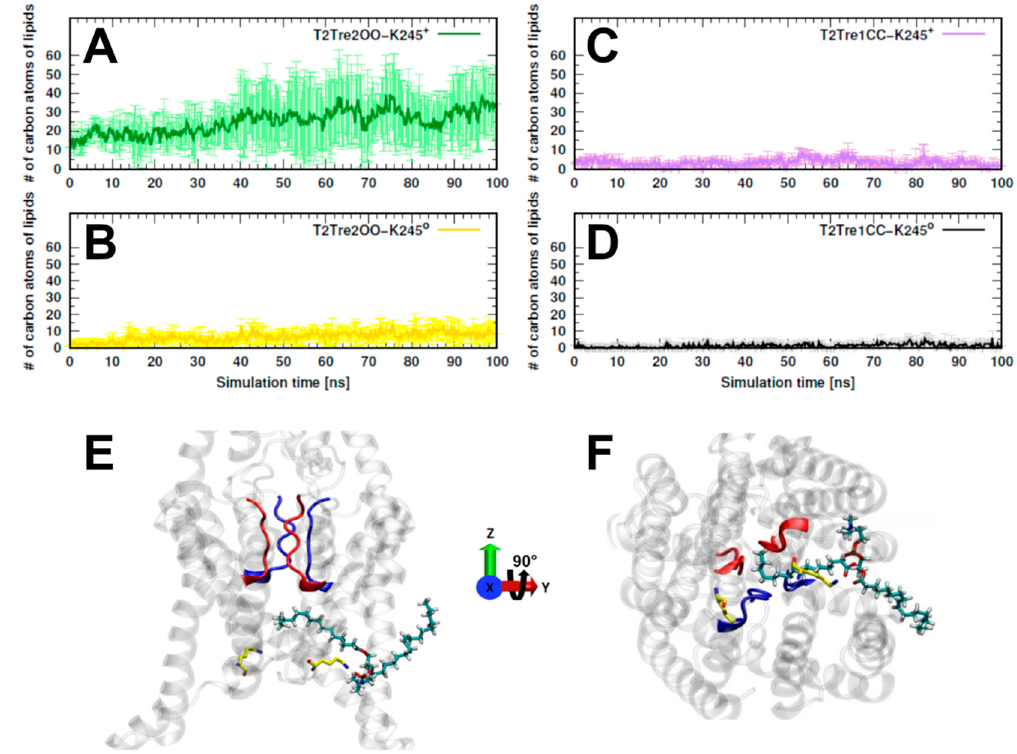
Figure 5. Evaluation of the lipids protruding toward the fenestrations and the central cavity during the entire simulation time. The entrance of lipids in the conduction pore and fenestrations were measured as a function of the number of carbon atoms belonging to the lipids and protruding into these regions. ( A , B ) The average of carbon atom number in three replicas for T2Tre2OO-K245 + and T2Tre2OO-K245 0 , respectively. Correspondingly to ( A , B ), they are shown for T2Tre1CC-K245 + and T2Tre1CC-K245 0 in ( C , D ). The figures ( E , F ) represent the frontal and intracellular views of a 1-palmitoyl-2-oleoyl-sn-glycero-3-phosphocholine (POPC) lipid molecule protruding through the side fenestration in the T2Tre2OO-K245 + simulation. K245 is shown in yellow.